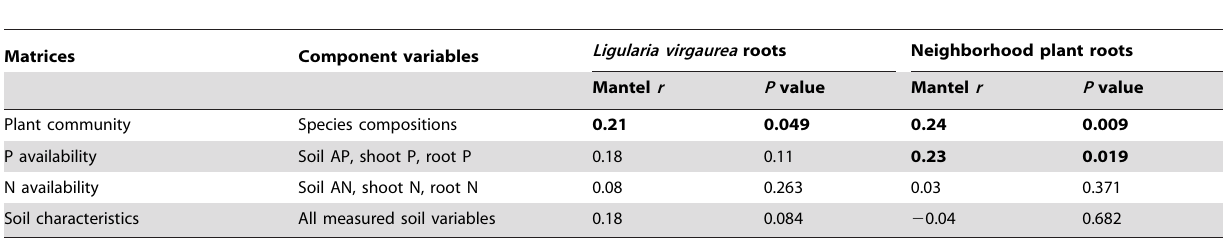
Table 2. Mantel tests between matrices of AM fungal community in the roots of Ligularia virgaurea and its neighborhood plants and matrices of N and P variables, plant community and soil